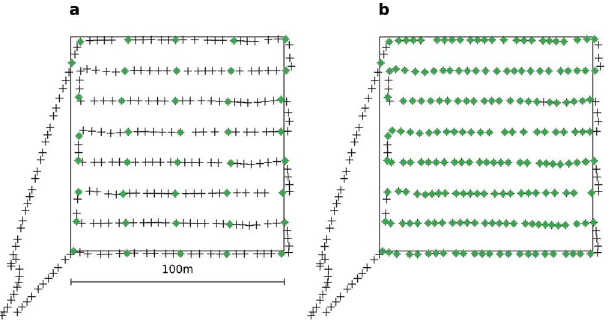
Figure 4. Example of location of image acquisition during a flight (black crosses) over a research plot of 100 × 100 m. Green circles indicate pictures selected for virtual flight plans for ( a ) 5 images, and ( b ) 25 images on every 100 m stripe.